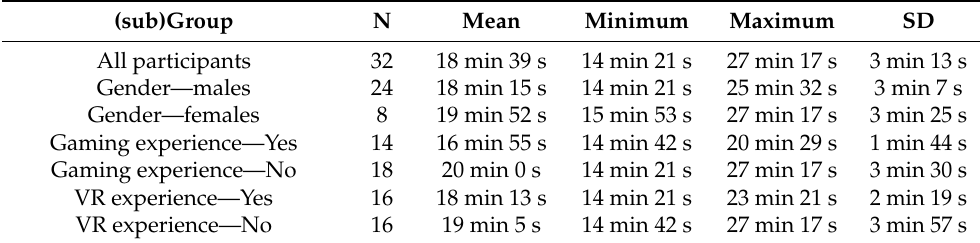
Table 2. Exposure time in virtual reality (VR), including tutorial level. The data presented is for all participants and subgroups based on gender, previous gaming and VR experience.